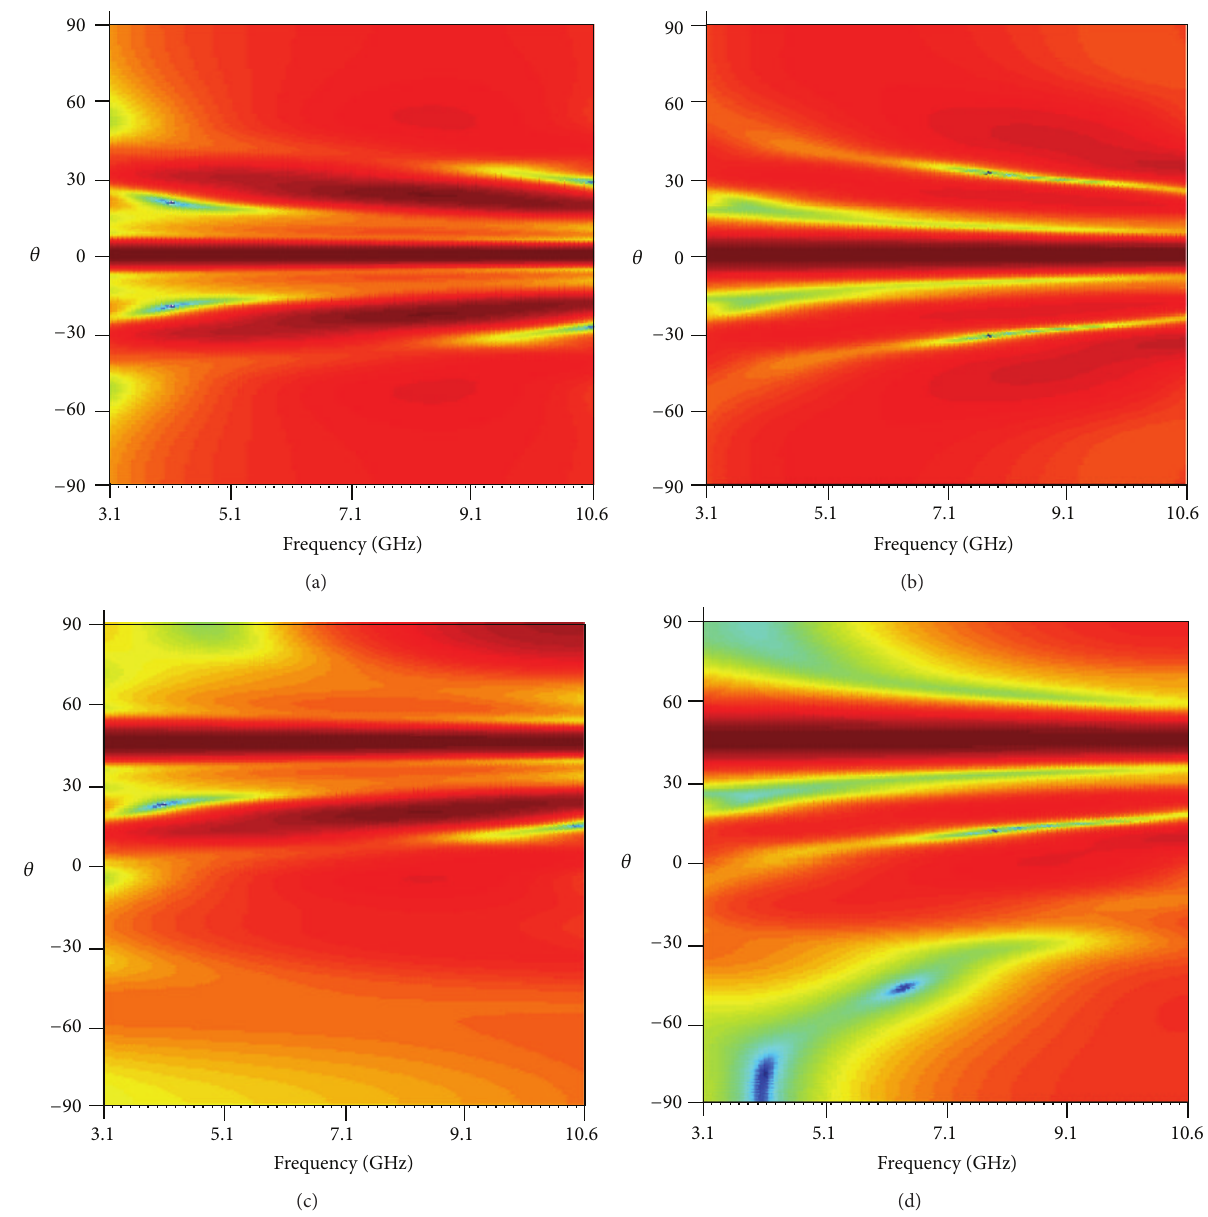
Figure 7: Spectrum in frequency of (a) CUSA at 𝜃 = 0 ∘ , (b) RA at 𝜃 = 0 ∘ , (c) CUSA at 𝜃 = 45 ∘ , and (d) RA at 𝜃 = 45 ∘ .